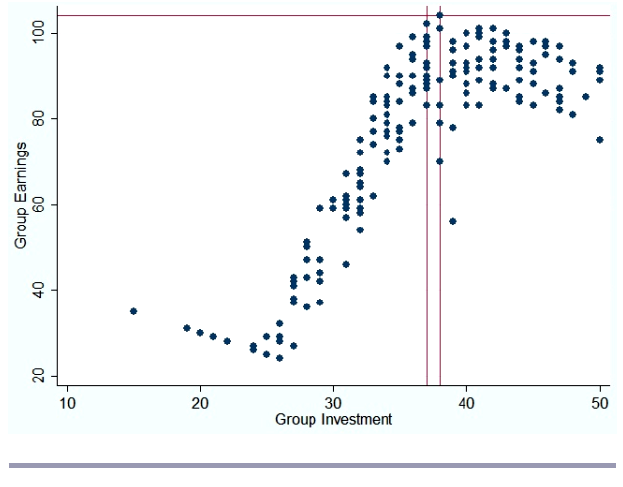
Fig. 4. Group earnings as a function of group investment in the baseline phase. Total number of observations = total number of groups × number of baseline rounds = 32 × 7 = 224.